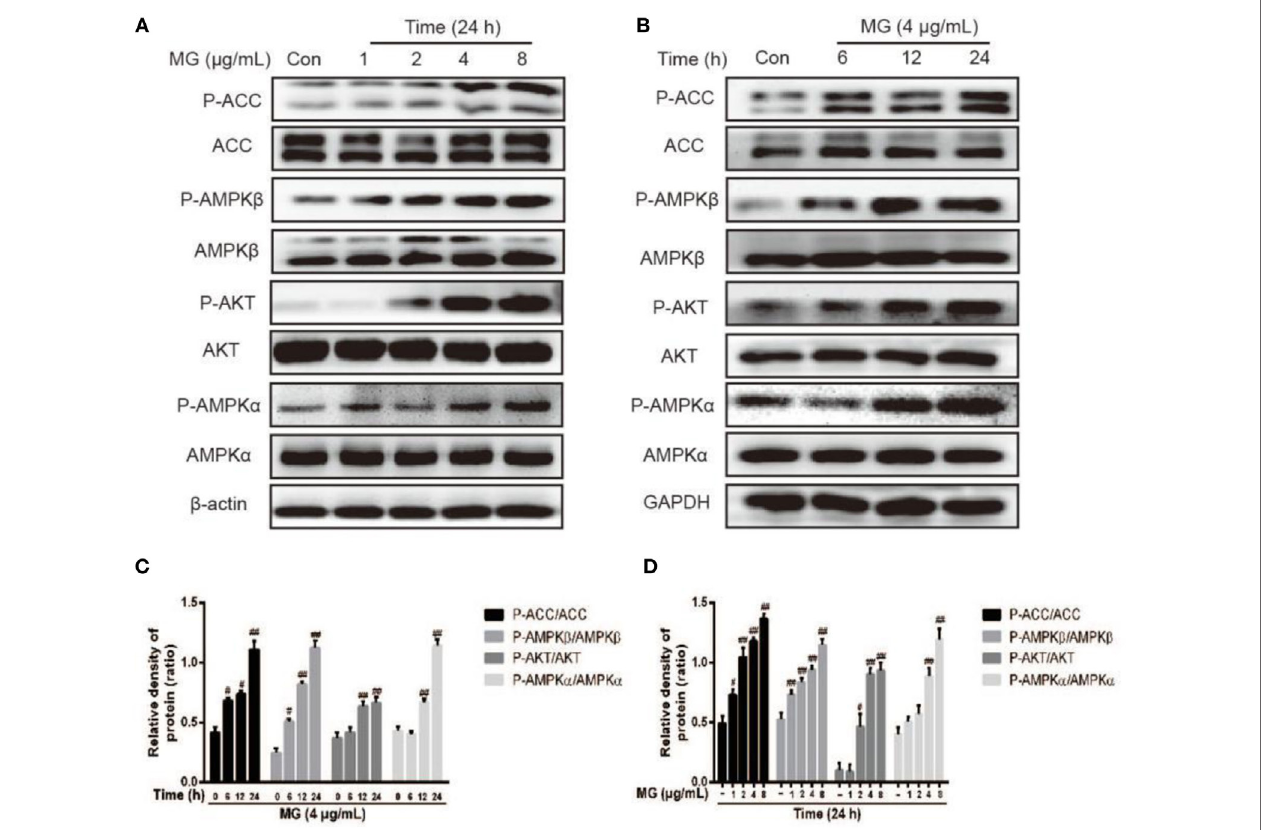
FigUre 3 | Effect of magnolol (MG) on the activation of AMPK α , AMPK β , acetyl-CoA carboxylase (ACC), and AKT in HepG2 cells. (a) HepG2 cells were treated with increasing concentrations of MG (1, 2, 4, and 8 µg/mL) for 24 h. (B) Cells were cultured with MG (4 µg/mL) for three time points (6, 12, or 24 h). All cell lysates were prepared and detected by western blot analysis for phosphorylated and total AKT, AMPK α , AMPK β , and ACC protein expression. (c,D) Quantification of P-AKT/AKT, P-AMPK α /AMPKa, P-AMPK β /AMPK β , and P-ACC/ACC protein expression was performed by software analysis. All data are expressed as the mean ± SD of three independent experiments. Statistically significant at # p < 0.05 and ## p < 0.01 vs. the control group (one-way ANOVA followed by Tukey’s